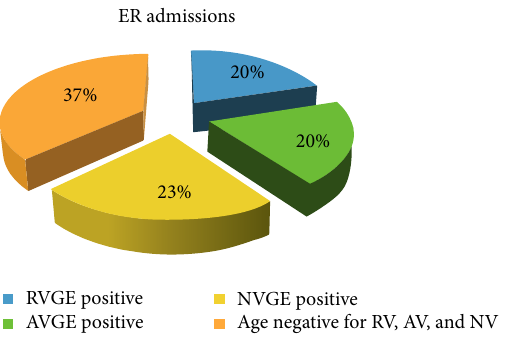
Figure 5: Comparison between ER access times during RVGE, AVGE, and NVGE episodes.